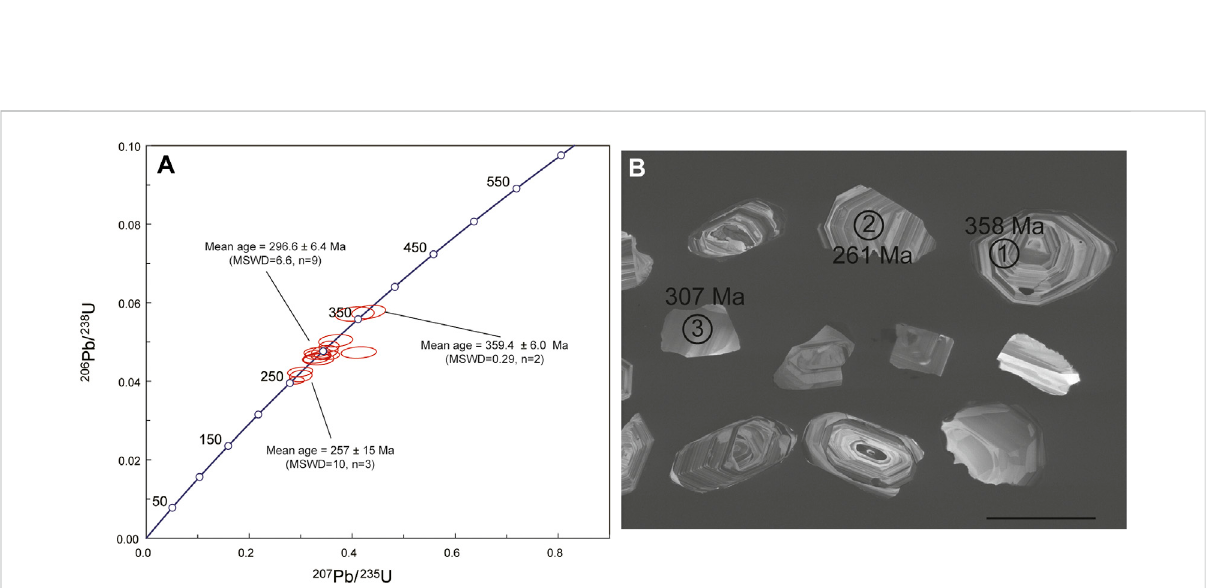
FIGURE 5 Concordia U ‒ Pb diagrams (A) and CL images (B) for the zircons of the basalt fromf the north HL